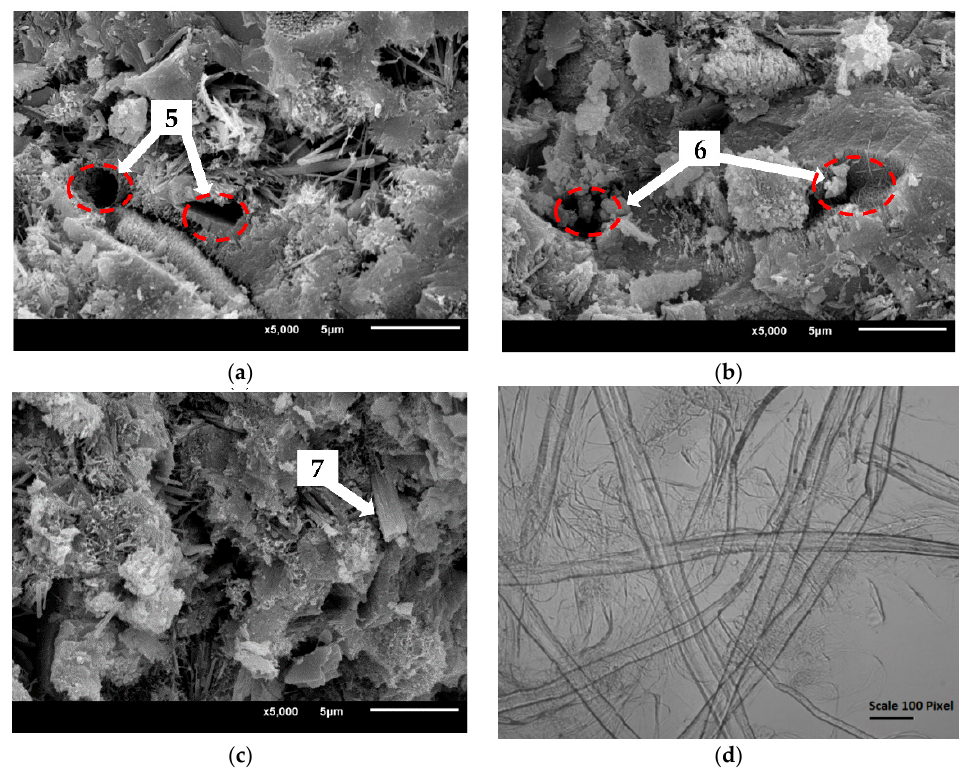
Figure 13. Scanning electron micrographs on a fractured sample of fiber-cement composites ( a ) non-carbonated; ( b ) 1 h carbonated sample; ( c ) 9 h carbonated sample; ( d ) refined fibers containing a large number of filaments.